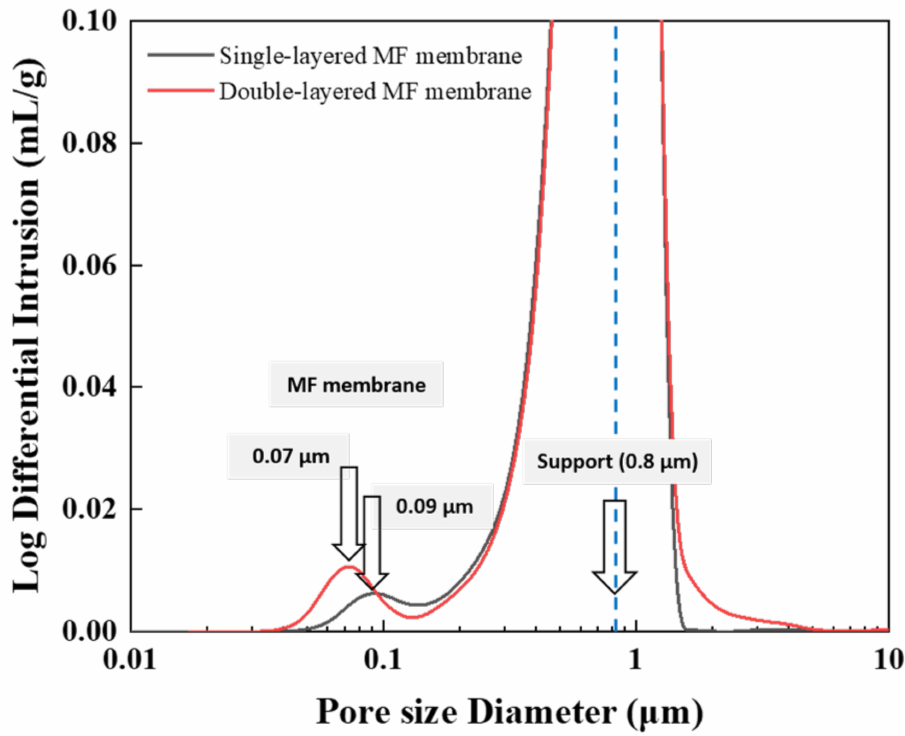
Figure 5. Pore size distribution of extruded support layer and alumina microfiltration (MF) membrane.